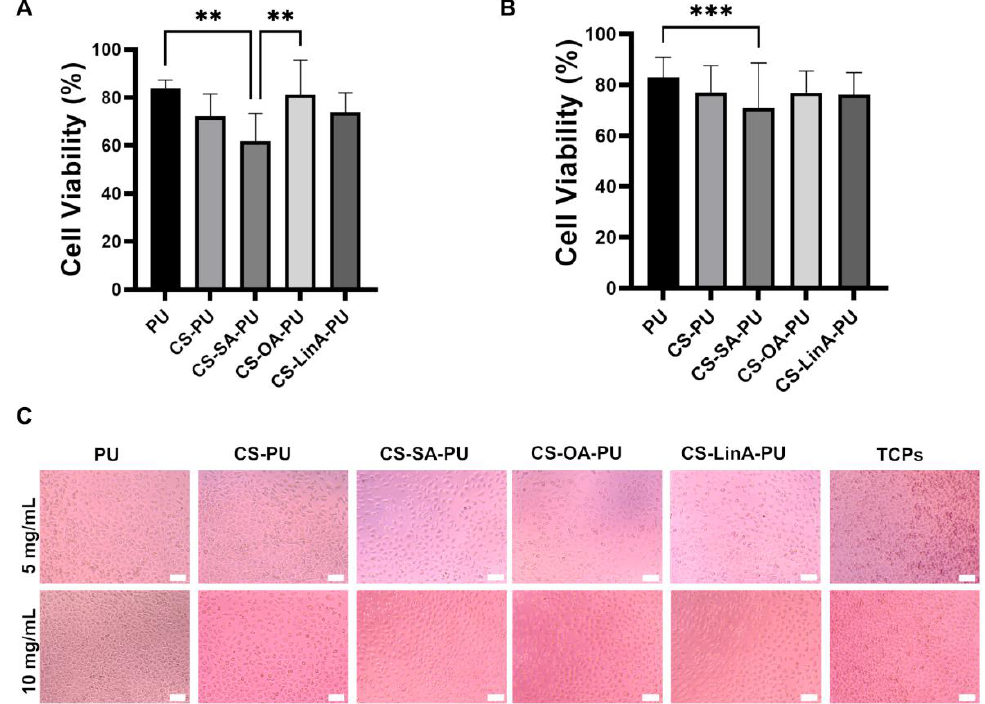
Figure 10. L929 cell viability after exposure to 24 h extracts of PU stents and coated PU stents ( A ) 5 mg/mL. ( B ) 10 mg/mL. Results were expressed as the mean ± standard deviation values of three independent assays conducted in triplicate. ***, p - value ≤ 0.001; **, p - value ≤ 0.01. *, p - value ≤ 0.05; ns, p -value > 0.05 (ns, no significant). ( C ) Cell morphology after exposure to 24 h extracts. The scale bar is 100 µm.